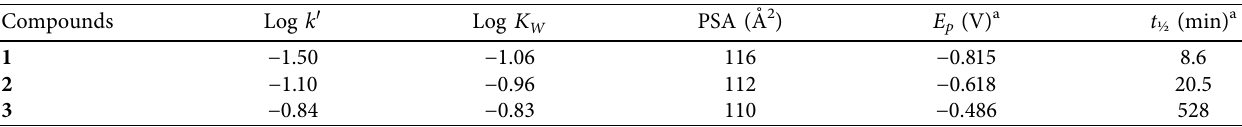
Table 1: Lipophilicity (HPLC log k ′ measured on a C K W measured on the immobilized artifcial membrane column), 18 column and log polar surface area (PSA), half-life ( t ½ at 37 ° C in the presence of a ten-fold excess of ascorbic acid), and reduction peak potential ( E p , V vs.